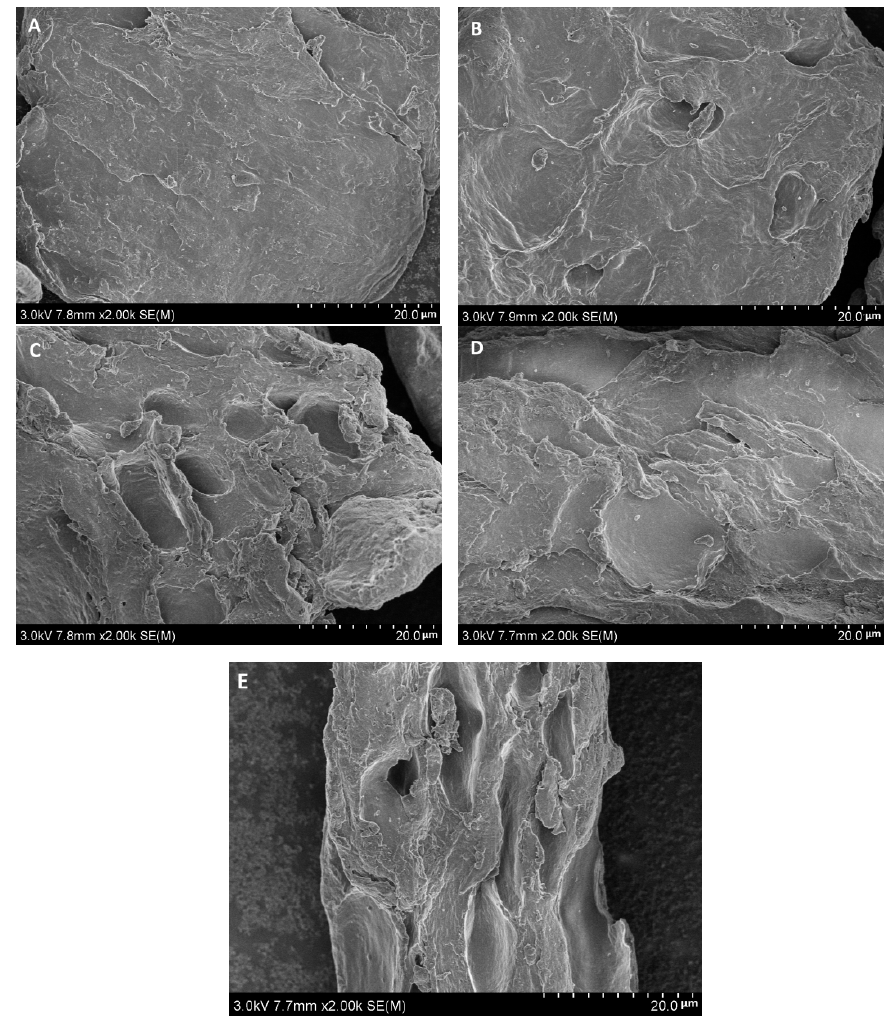
Figure 4. Effect of the synthetic method on the microstructure of carboxymethyl agar: ( A ) original agar, ( B ) CAg1, ( C ) CAg2, ( D ) MAg1, and ( E ) MAg2.